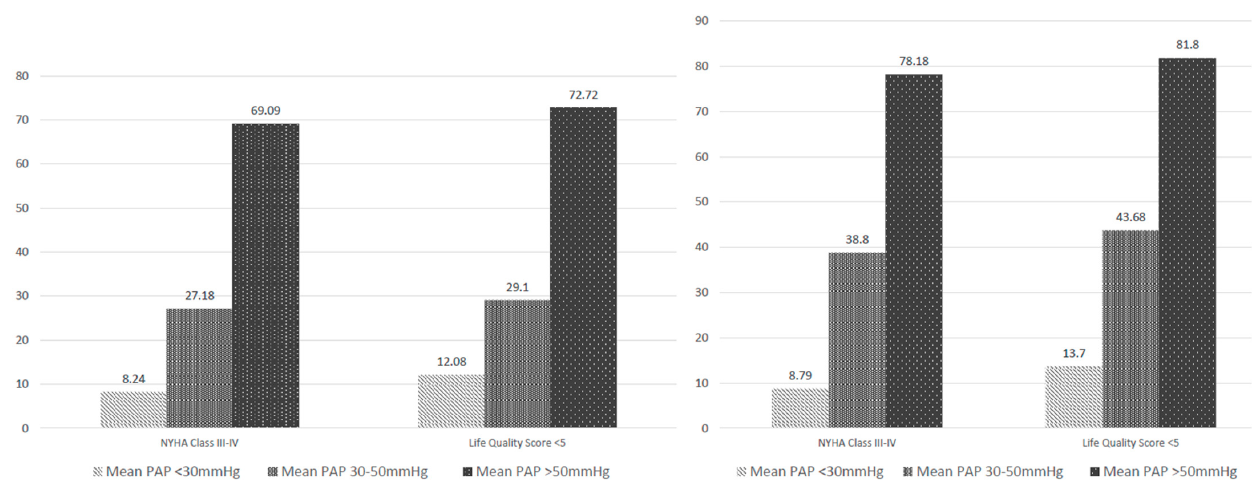
Figure 5. Patients’ evolution from the point of view of NYHA class and health-related quality of life score depending on the presence of pulmonary hypertension.